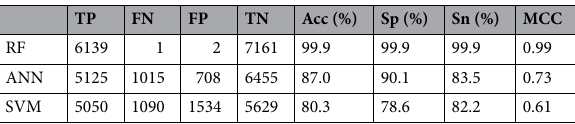
Table 3. Jack-knife testing results of all predictors.